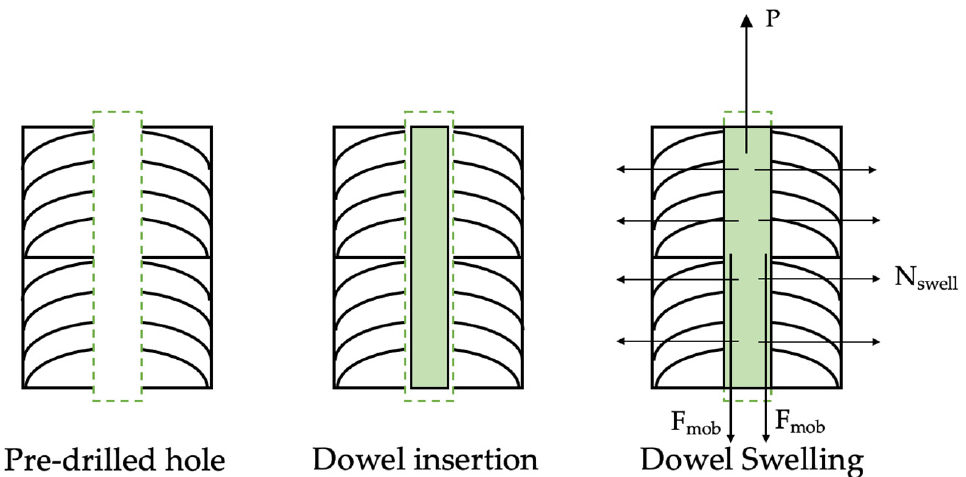
Figure 2. The friction-induced locking effect of a swelling wooden dowel joining two lamellae. Redraw from [18] .